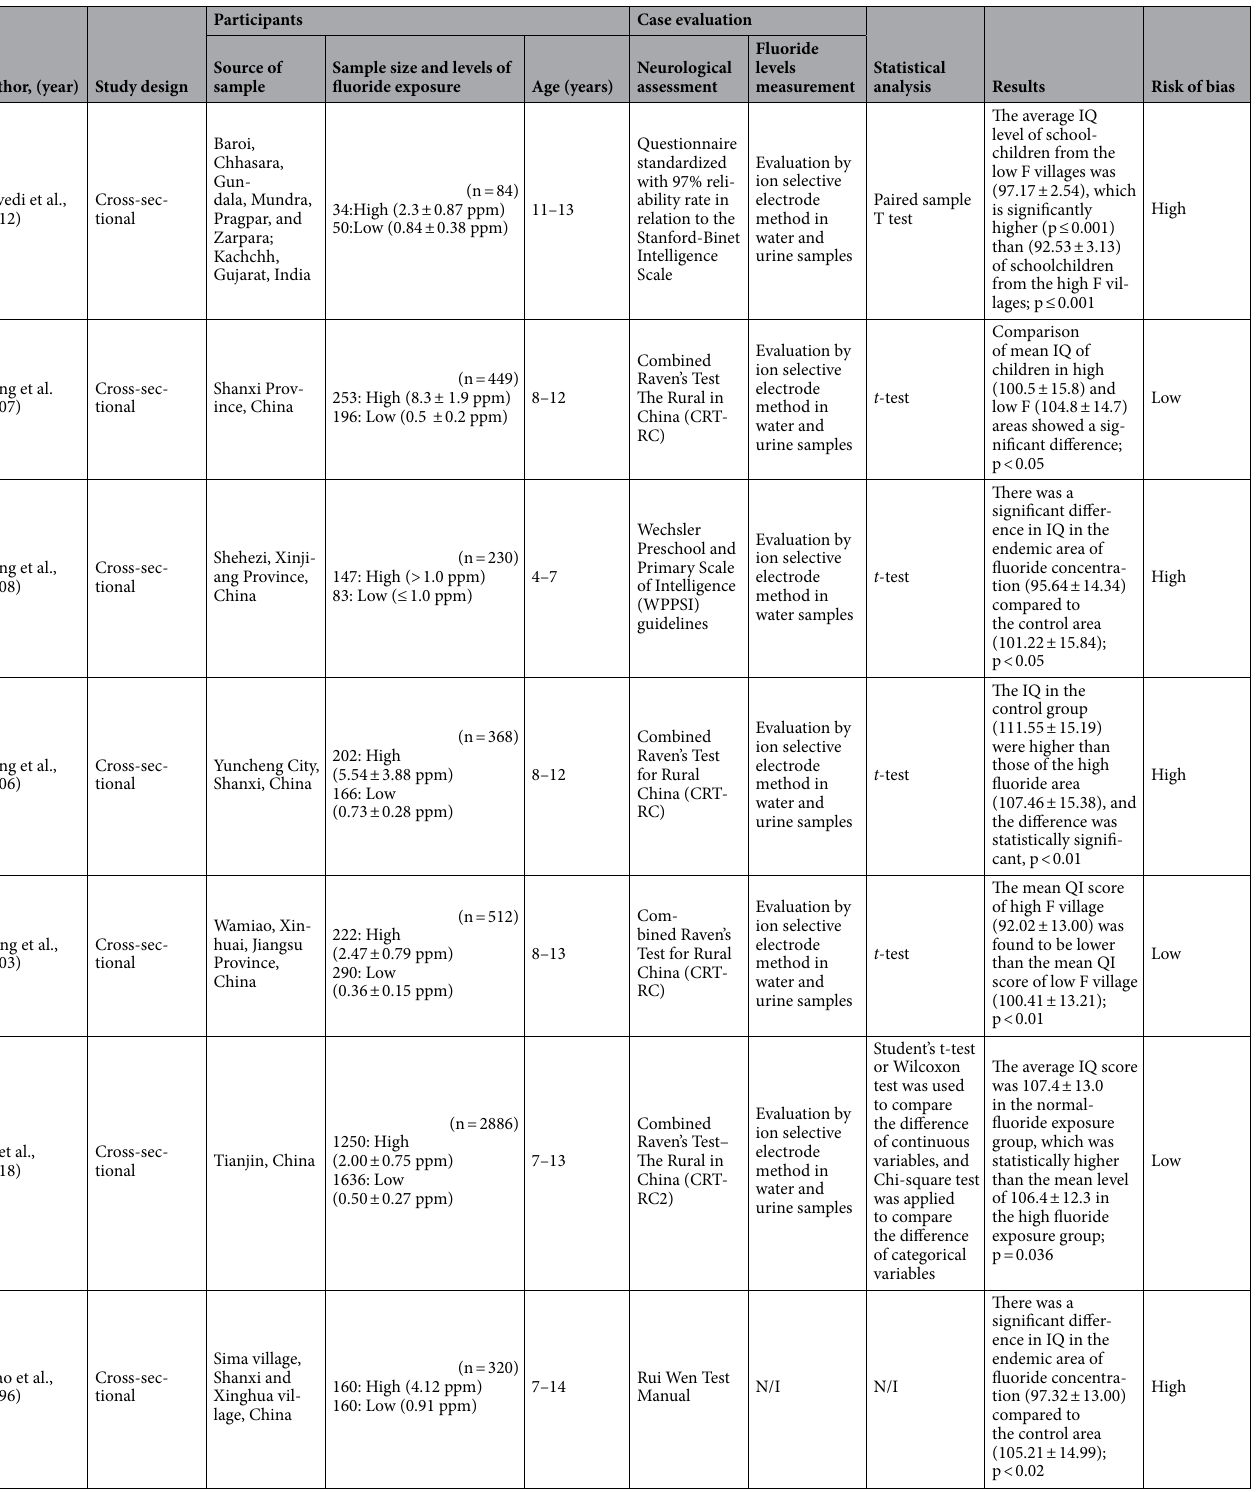
Table 1. Data extraction from included studies. IQ, Intelligence Quotient; F, fluoride; N/I, no information; SPADNS (sulfo phenylazo dihydroxy naphthalene disulfonic